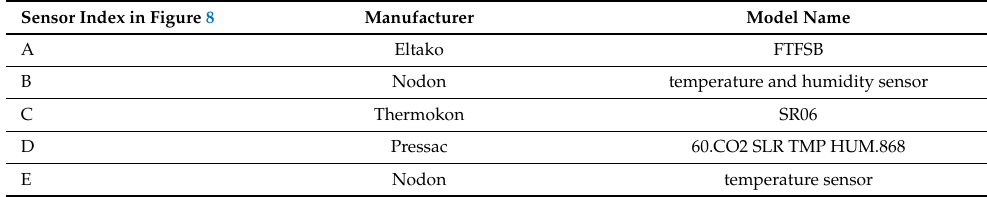
Table 7. Sensor models for the comparison of temperature measurements.